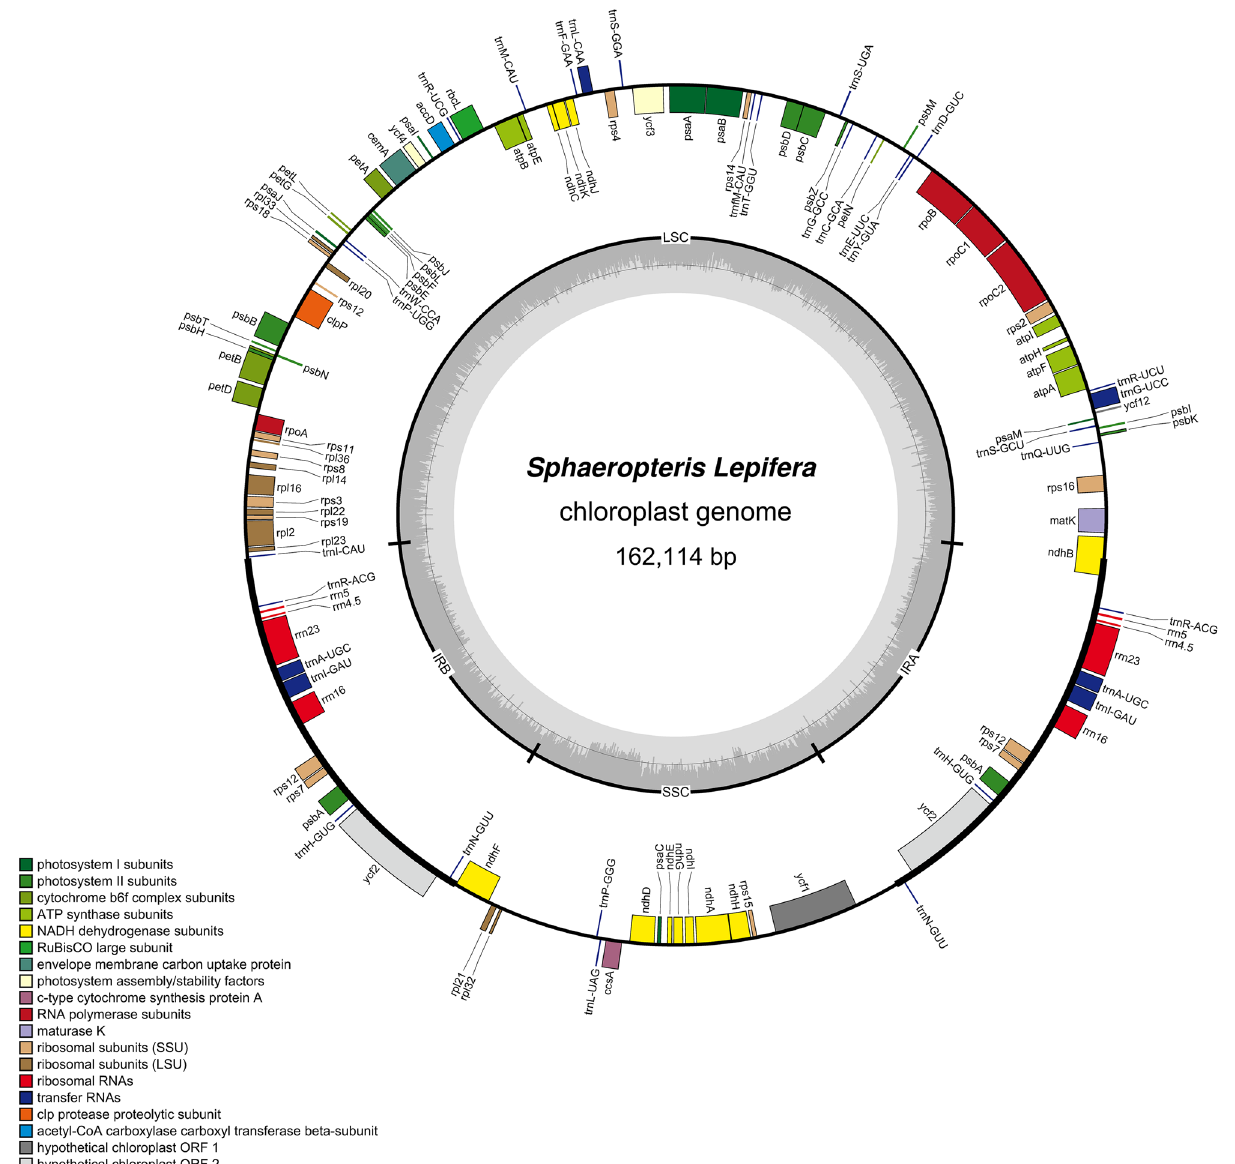
Figure 1. Chloroplast genome map of S. lepifera . Forward-coding genes are located outside the circle, and reverse-coding genes are located inside the circle. The gray circle inside represents the GC content.